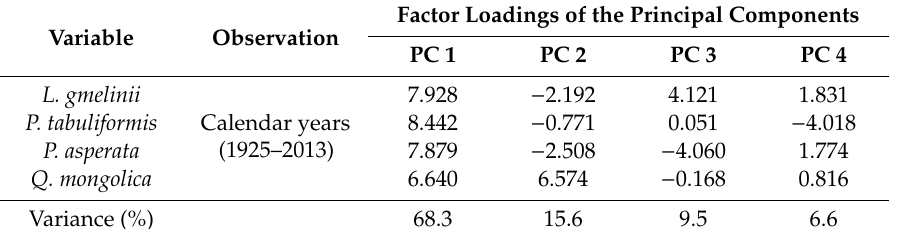
Table A2. Summary statistics of the Principal Components Analysis (PCA)-matrix of factor loadings. Variable = detrended ARI chronologies of the four tree species.